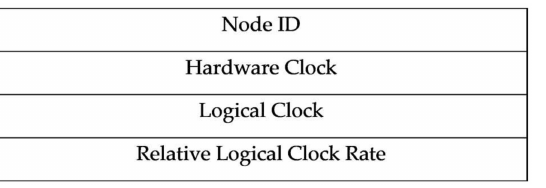
Figure 1. Median Kalman-filtering Time Synchronization (MKTS) packet